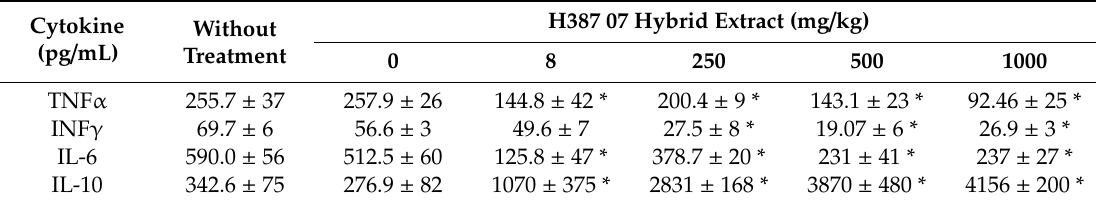
Table 2. Concentrations of serum inflammatory cytokines from mice treated intraperitoneally with 8, 250, 500 and 1000 mg / kg extract of the Sechium H387 07